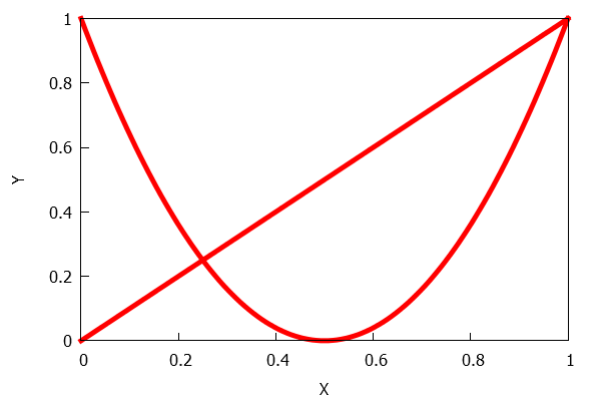
) 2 originates the ω -limit set ω 2